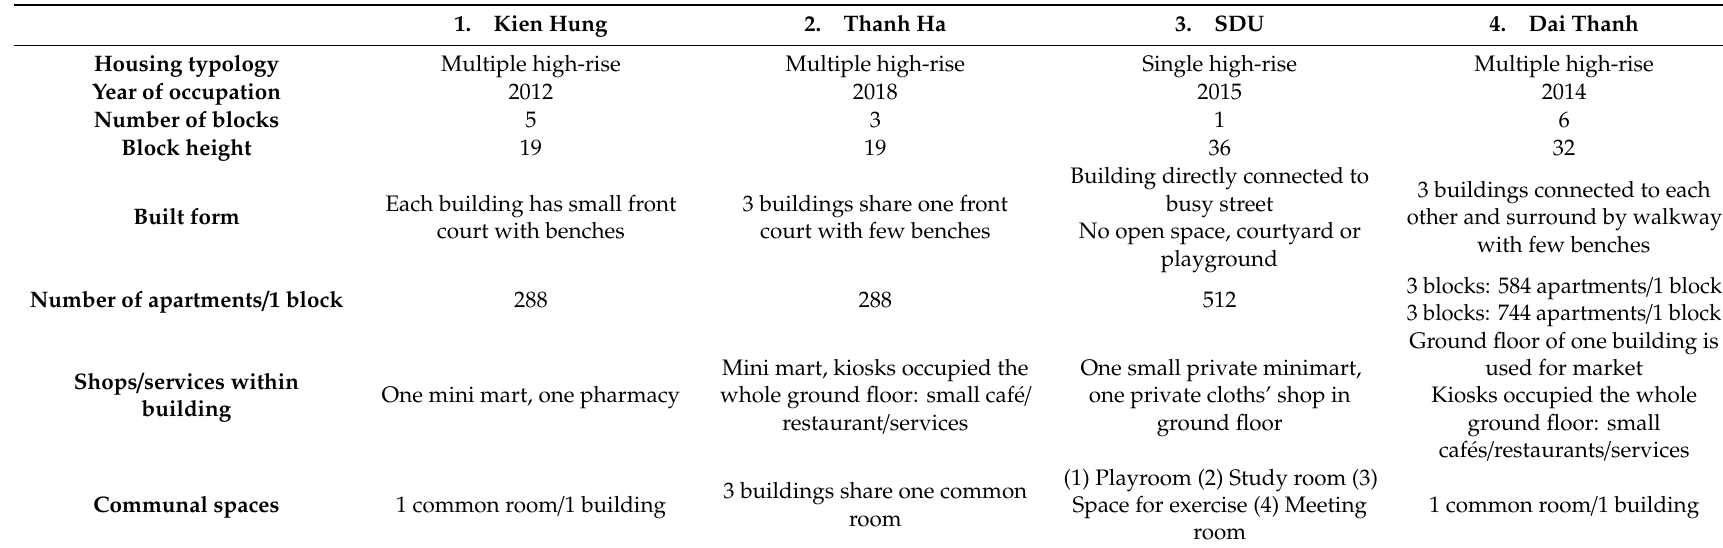
Table 2. Neighborhoods